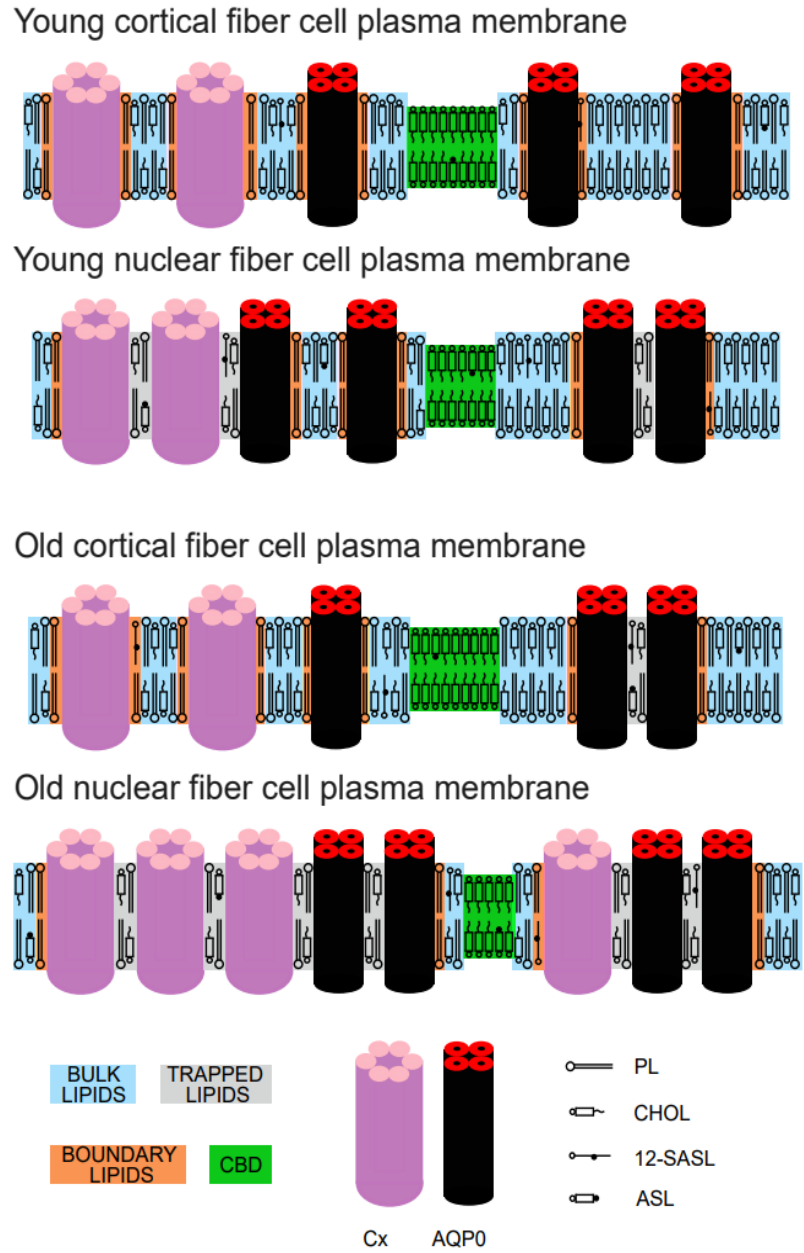
Figure 6. Schematic drawing showing the changes in the organization of lipids and proteins in intact, human eye lens fiber cell plasma membranes between cortical and nuclear membranes from young donors (between 0 and 20 years old) and between cortical and nuclear membranes from old donors (between 60 and 70 years old). Purported lipid domains induced by the presence of integral membrane proteins (mainly connexins and aquaporins) and high Chol content are indicated. The cytoskeletal and peripheral membrane proteins are not shown in the schematic. The PL spin label 12-SASL is distributed between bulk lipids, boundary lipids, and trapped lipids, while the Chol analog ASL is distributed between bulk lipids, trapped lipids, and CBD. Note that Chol is excluded from boundary lipids. The nitroxide moiety of 12-SASL and ASL is indicated by a black dot.